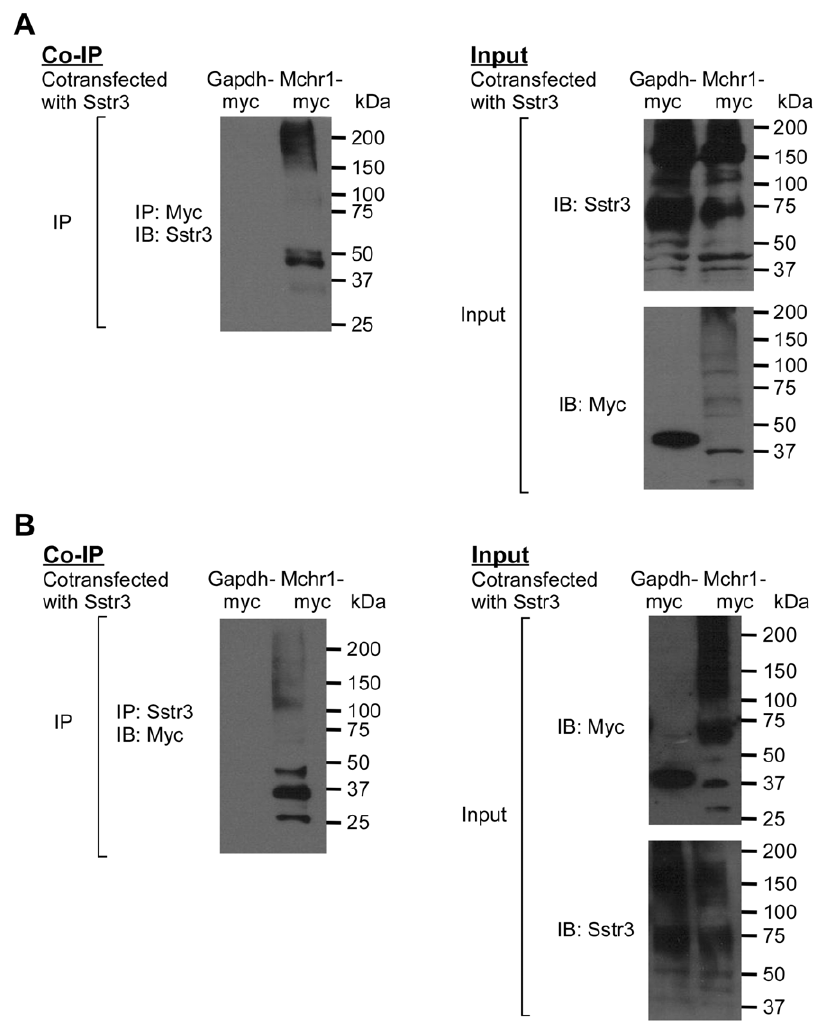
Figure 5. Mchr1 and Sstr3 proteins interact. Sstr3 was co-expressed with myc-tagged glyceraldehyde-3-phosphate dehydrogenase (Gapdh- myc) or myc-tagged Mchr1 (Mchr1-myc) in HEK293T cells. (A) Cell extracts were immunoprecipitated (IP) with an anti-myc antibody. Immunoprecipitates were analyzed by western blotting (IB) with an anti-Sstr3 antibody (left). Note that Sstr3 is immunoprecipitated with Mchr1, as indicated by the 45 kDa band, but not Gapdh. (B) In the reverse experiment, cell extracts were immunoprecipitated (IP) with an anti-Sstr3 antibody and immunoprecipitates were analyzed by western blotting (IB) with an anti-myc antibody (left). Note that Mchr1 is immunoprecipitated with Sstr3, as indicated by the 37 kDa band, but not Gapdh. The input, confirming expression of each protein, is also shown (right). Sstr3 appears as a 45 kDa band, which agrees with its predicted size, and 75 kDa and 150 kDa bands, which may represent higher order oligomers. Gapdh and Mchr1 are observed as 39 kDa and 37 kDa bands, respectively. The expression pattern of GPCRs often results in a multi-band pattern due to various oligomeric combinations and post translational modifications.